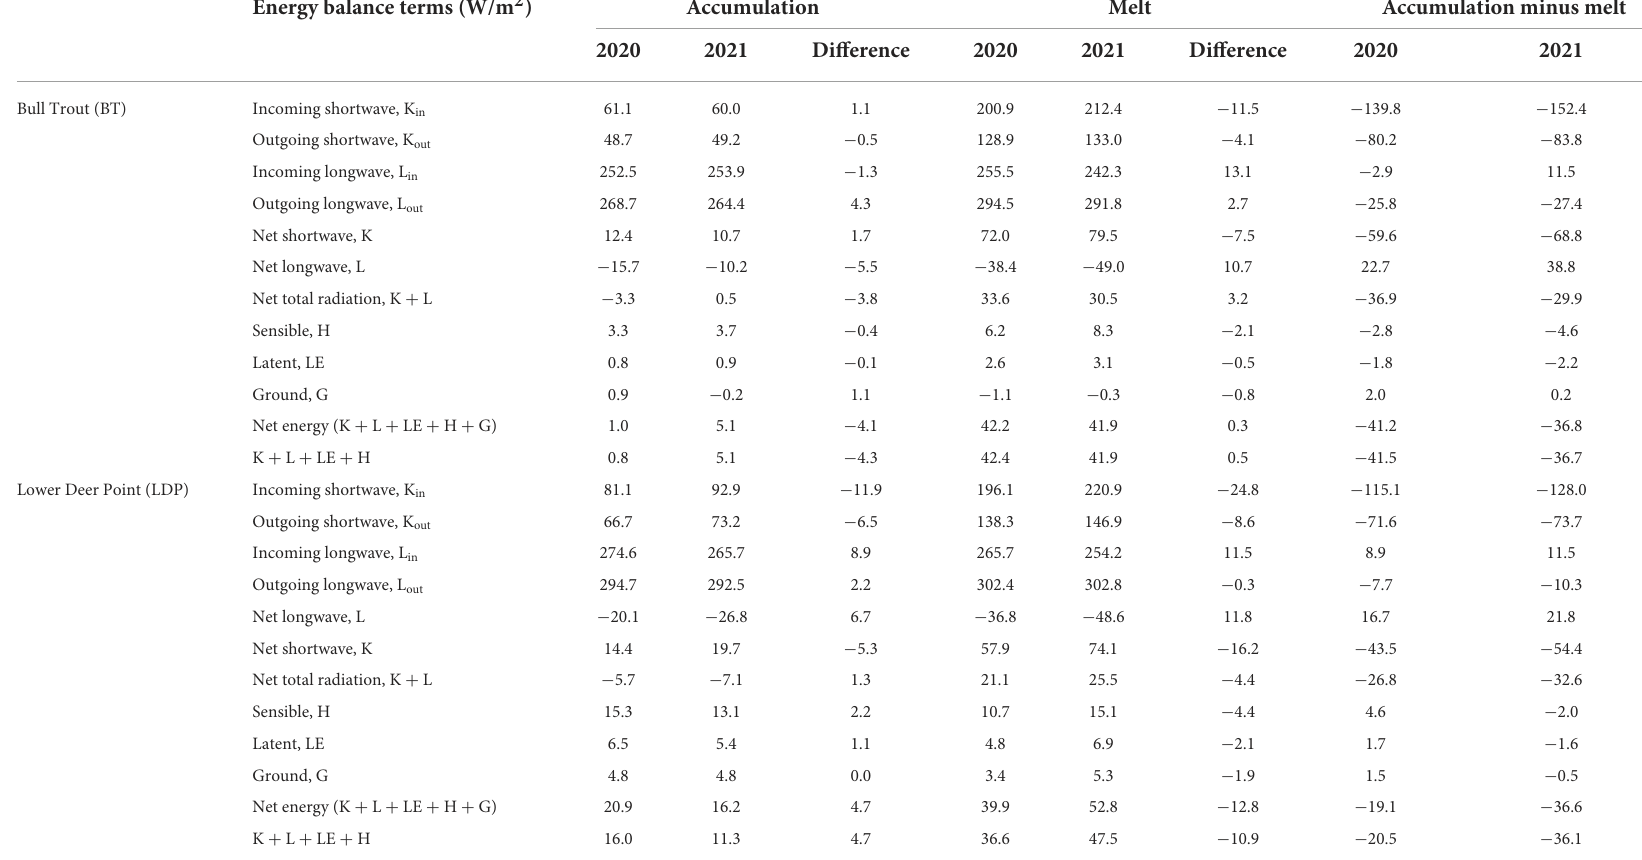
TABLE 2 Daily average snow surface energy balance at the weather station and SNOTEL for the BT and LDP accumulation and melt periods for each year, the difference between the years (WY 2020–WY 2021) and accumulation and melt